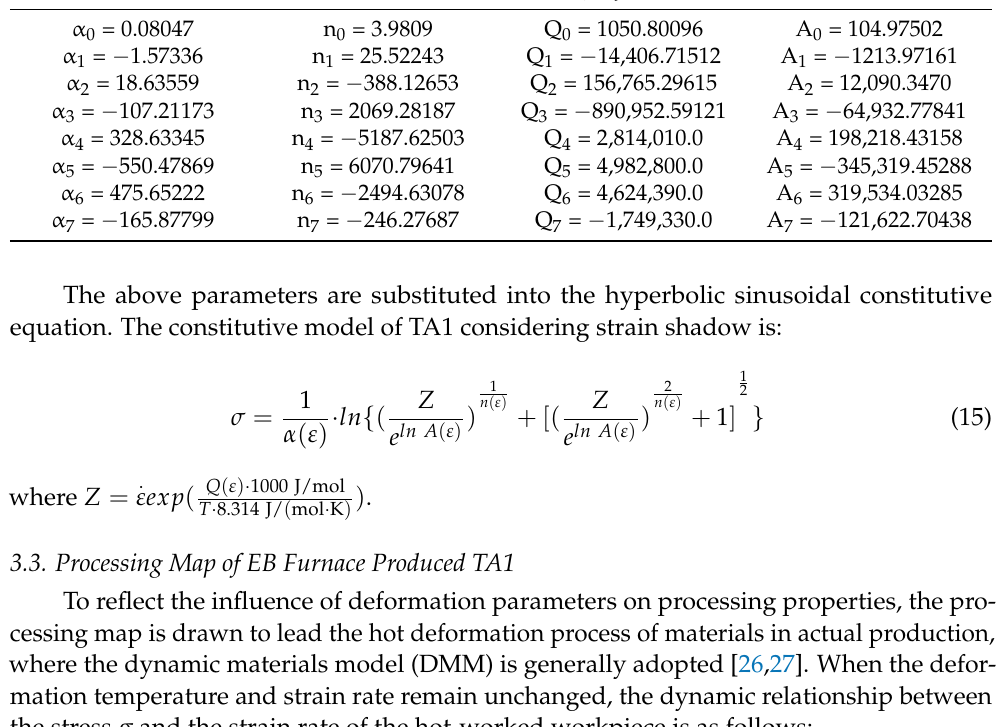
Figure 8. Relationship between material constants and true strain by fitting with seventh-order